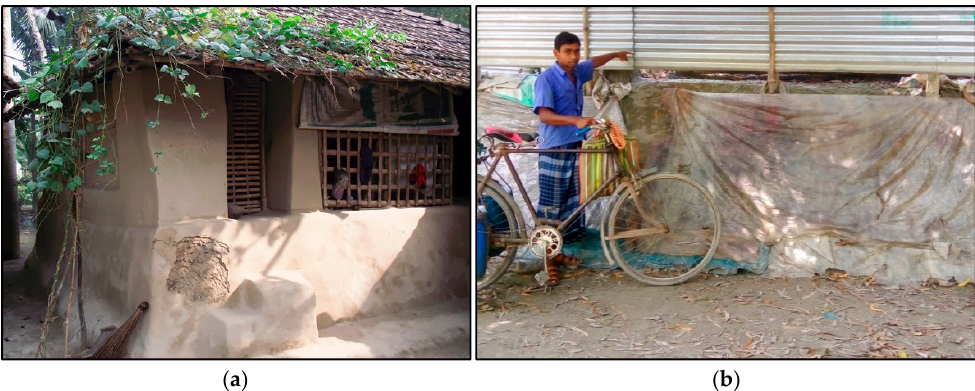
Figure 4. ( a ) Mud house with elevated plinth; ( b ) person denoting the flood water height in 2017 in Type 2 settlement (Image source: Authors).